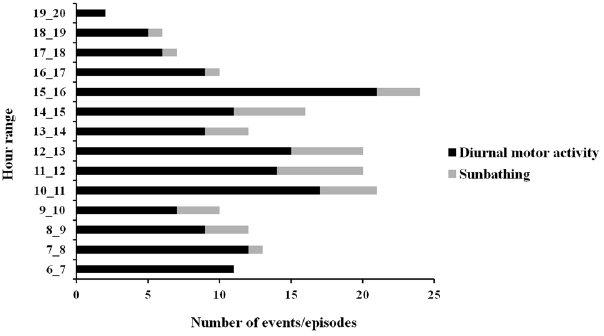
Figure 3. Number of hourly diurnal motor activity events and sunbathing episodes recorded in the monitored settlement during the camera-traps monitoring.